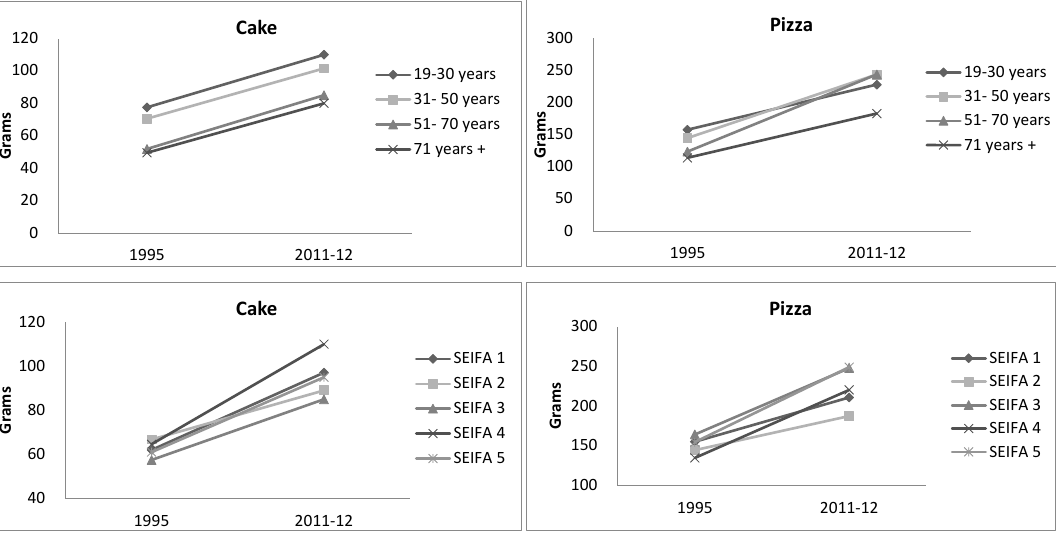
Figure 3. Typical portion size trends of cakes and pizza from 1995 to 2011–2012 according to age and Socio-Economic Indexes for Areas (SEIFA) groups. * p <